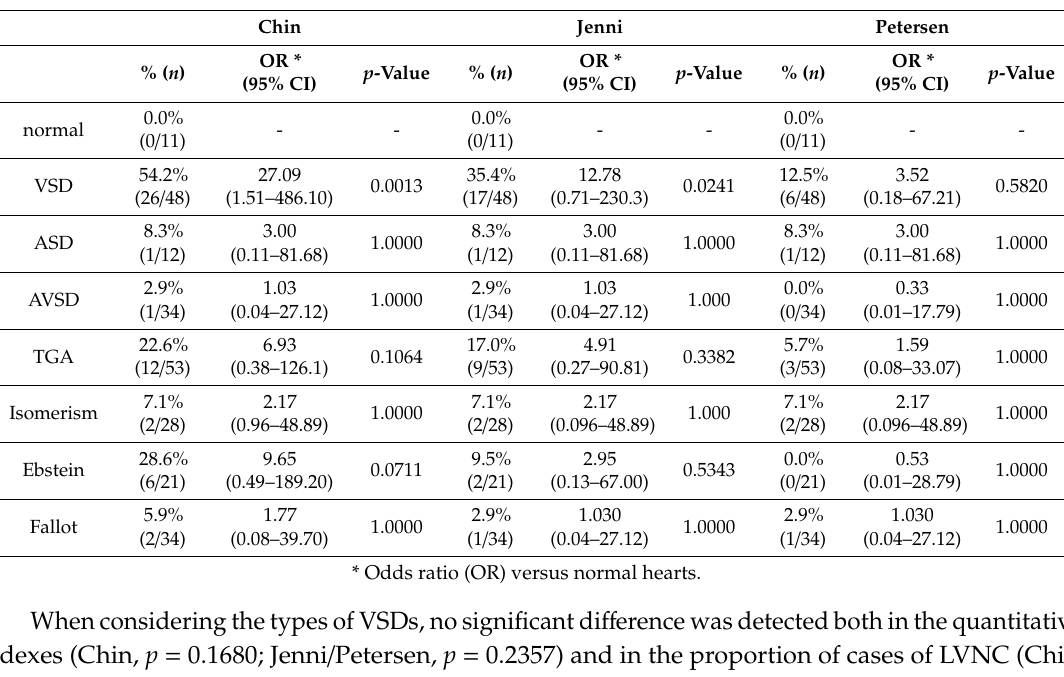
Table 4. Percentage of hearts presenting LVNC according to Chin, Jenni, and Petersen (apex).